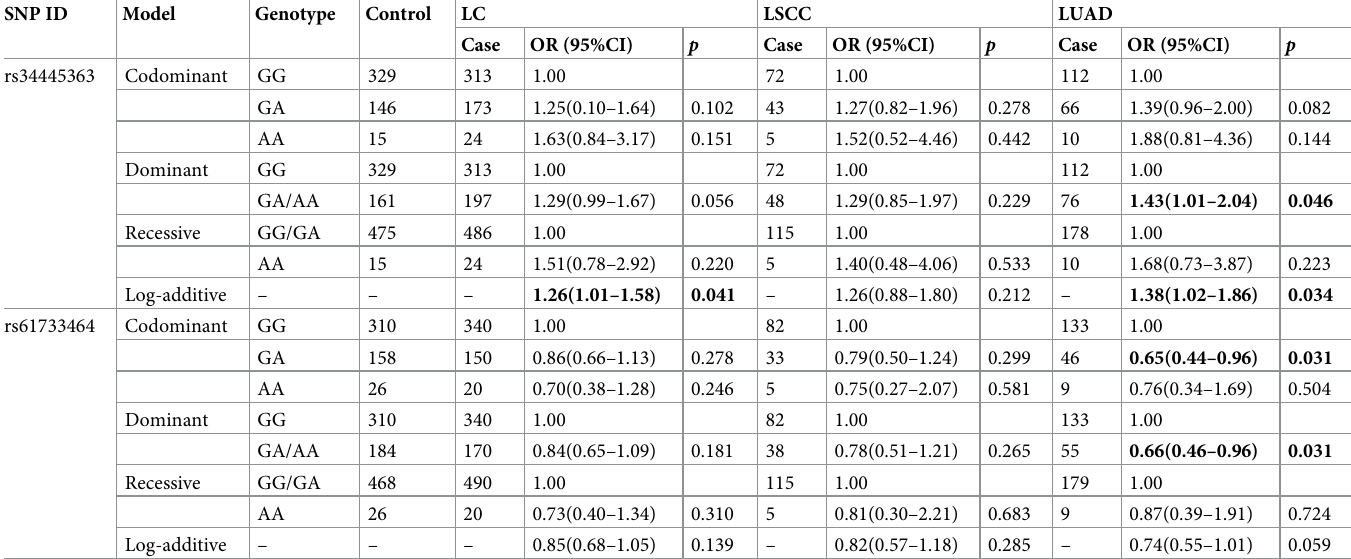
Table 3. Distribution of genotypes of COL6A4P2 polymorphism depicting their association with lung cancer risk and its histological